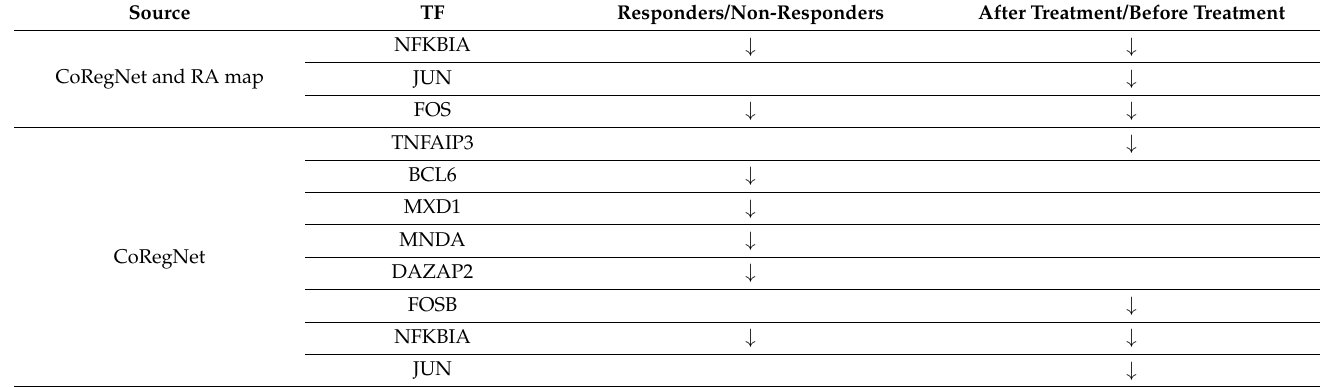
Figure 4. Integrative global network for rheumatoid arthritis. RA map upstream regulators are bound to TFs identified in the CoRegNet co-regulatory network. Matching TFs are coloured in purple (6), matching genes/proteins are coloured in blue and orange (16), upstream regulators from the RA map are coloured in orange (222), CoRegNet TFs are coloured in pink (13), and CoRegNet target genes are coloured in blue (357). Inhibitions are represented with blunt red arrows, and activations are represented with grey arrows. Transcription factors are depicted in diamond shapes, while upstream regulators and target genes are depicted using round shapes. Table 2. Transcription factors from the global network for RA with at least one differentially expressed gene overlapping from the analysis of (a) responders/non-responders RA patients to anti-TNF treatment (37 and 41 RA patients treated with adalimumab and etanercept, respectively) and (b) after/before anti-TNF treatment of RA patients (two different cohorts of 40 and 36 RA patients from baseline and after three months treatment with Infliximab or Adalimumab). ↓ denotes